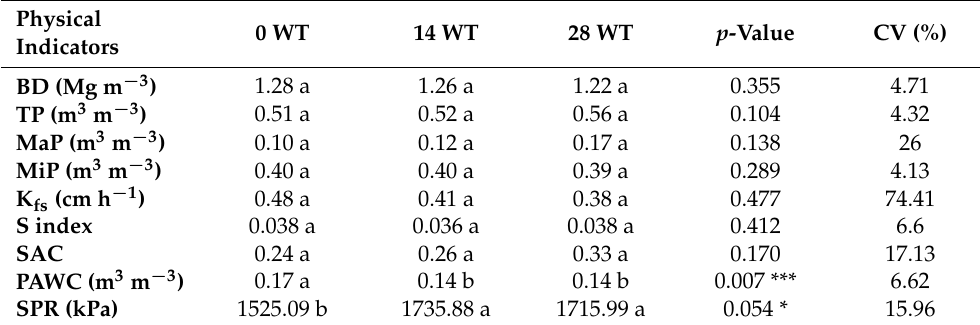
Table 4. Physical indicators of the wheel traffic at a depth of 0.05–0.15 m.